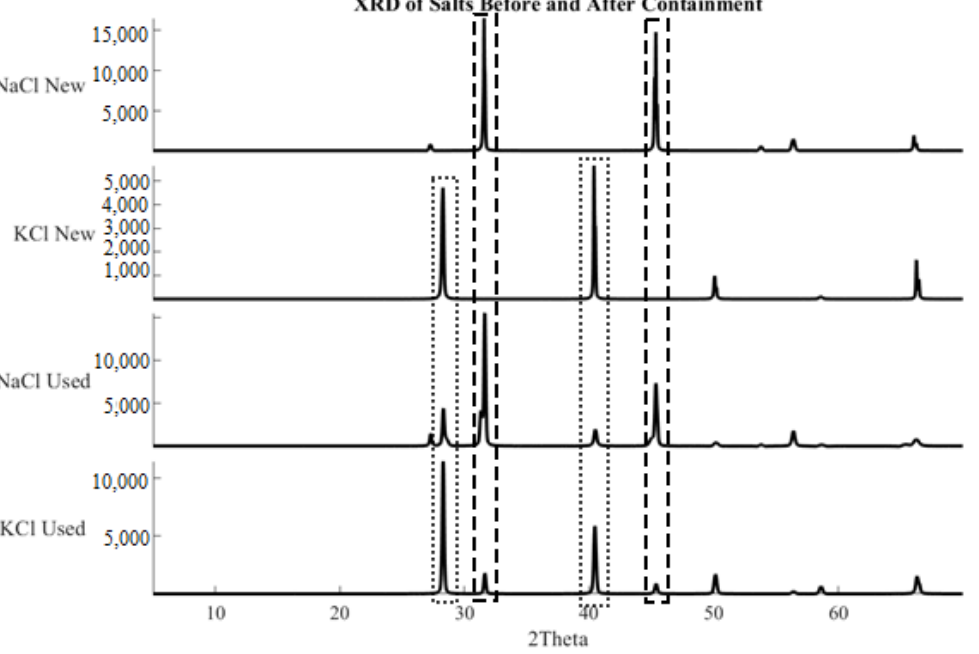
Figure 9. X-ray diffraction patterns of NaCl and KCl before and after prolonged heating in ASH-G composites. Salt samples after prolonged exposure to ASH-G show the presence of both Group 1 chlorides.